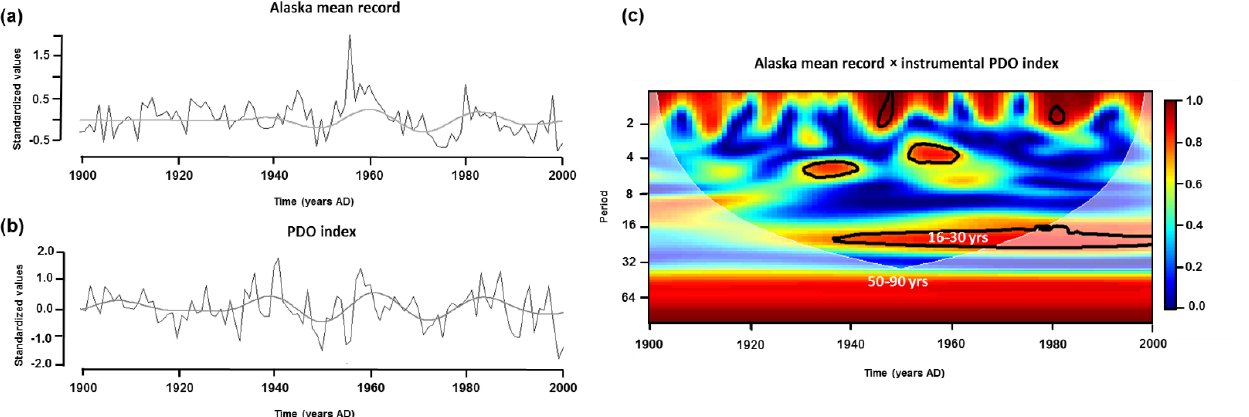
Figure 10. Wavelet coherence analysis between the Alaskan mean record and instrumental PDO index during the AD900–2000 period. (a) Alaskan mean record (this study) and (b) instrumental PDO index (Mantua et al., 1997). Grey lines correspond to wavelet reconstructions of the ∼ 16–30-year periodicity highlighted on the wavelet coherence spectrum (c) . Colors on the coherence wavelet spectrum represent correlation in both time and frequency domain. (Red equals the highest correlation and blue the lowest.) The white line corresponds to the cone of influence. A confidence level of 95% ( α = 0.05) is indicated with the black